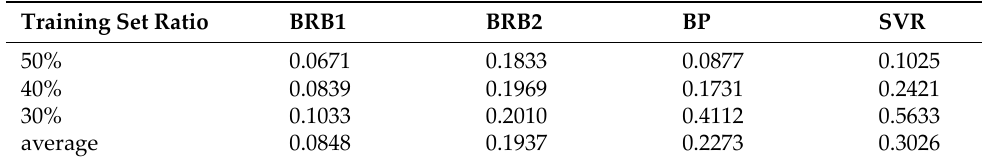
Table 19. Comparison results of different methods.